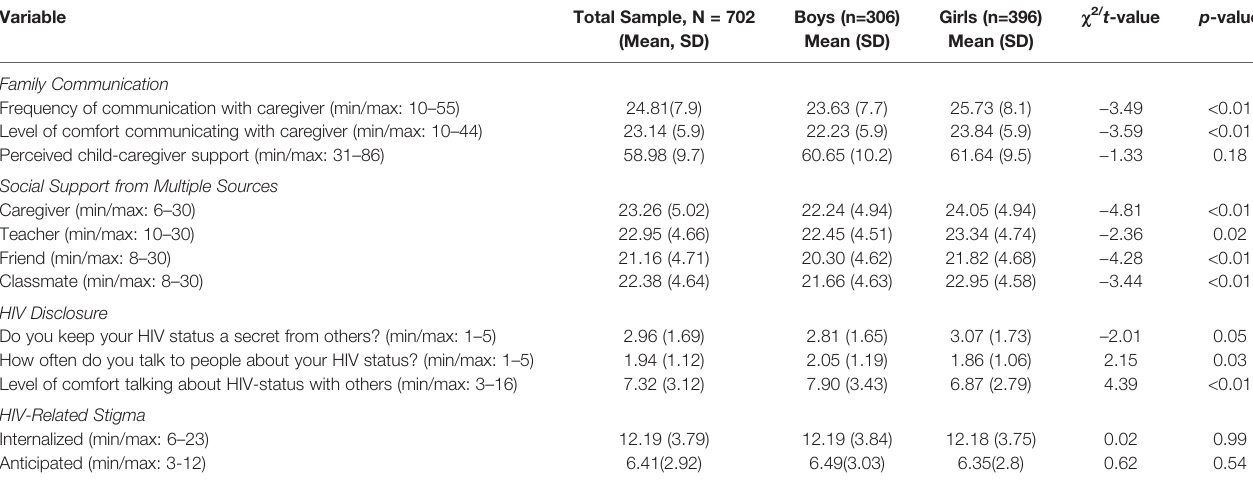
TABLE 2 | Family Communication, Social Support, HIV Disclosure and HIV-Related Stigma (N =